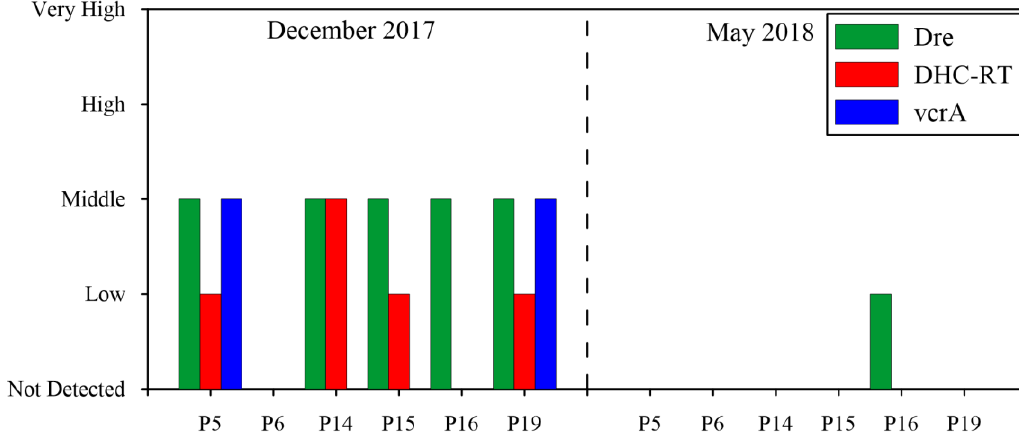
Figure 9. Results of BMT analyses. Sampling campaigns of December 2017 and May 2018. The y-axis shows the quantity of bio-molecular markers detected at each monitoring well from not detected to very high abundance.